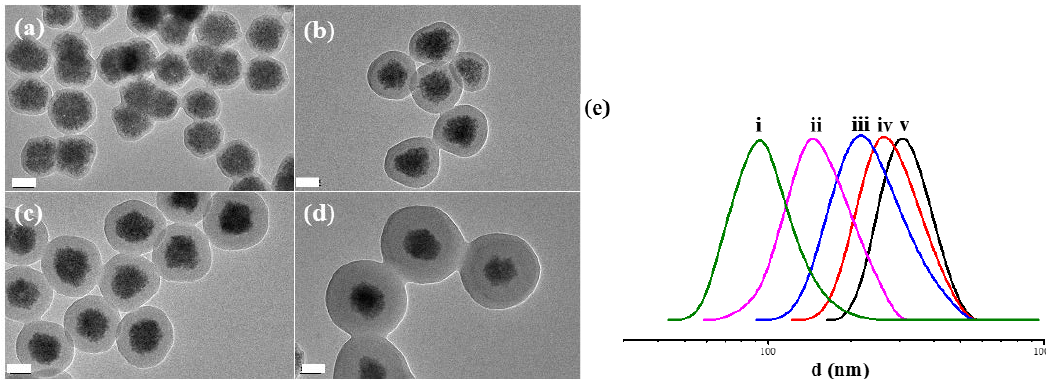
Figure 5. TEM images of MSP@PNAMAm with different thickness of polymeric shell prepared with different solid contents of ( a ) 0.25%; ( b ) 0.375%; ( c ) 0.5%; ( d ) 0.625%, the scale bar is 100 nm; ( e ) DLS